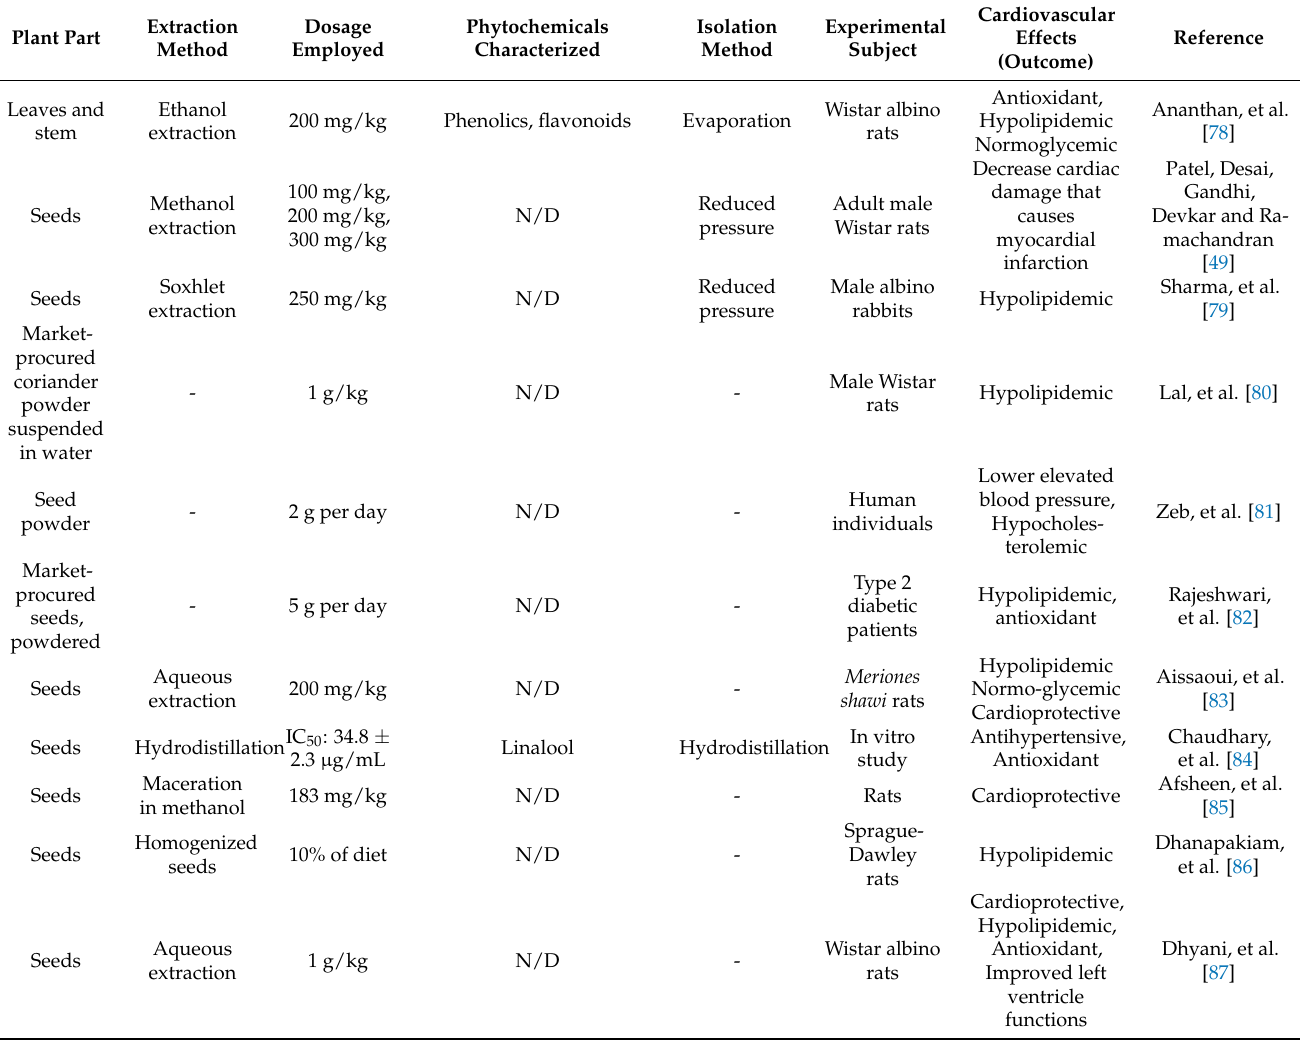
Table 4. Cardiovascular potential of C. sativum from previous studies with details about the plant part used, extraction method, dosage em-ployed, phaytochemicals characterized, and isolation